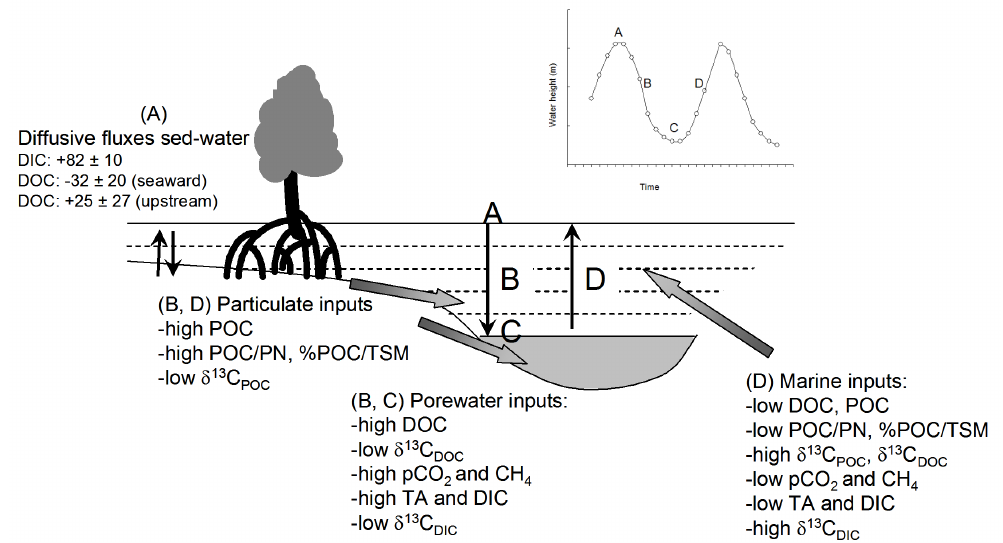
Fig. 8. Conceptual scheme of exchange processes for dissolved and particulate matter during a tidal cycle in the tidal creeks. Letters A, B, C, and D refer to high tide, ebb, low tide, and flood, respectively. Fluxes (E. Kristensen, unpublished) are presented in mmolm − 2 d − 1 , positive fluxes are towards the water column, negative fluxes indicate net uptake by